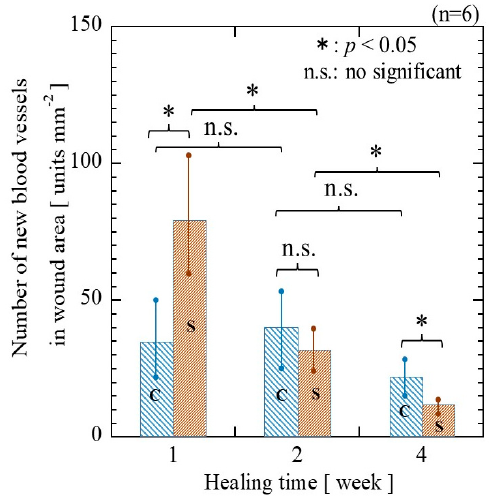
Figure 10. Graph depicting the number of newly formed blood vessels on the wound site after 1, 2, and 4 weeks. C and S mean control and simonkolleite groups, respectively. * = signi fi cant di ff erence ( p < 0.05) and n.s. = not signi fi cant.